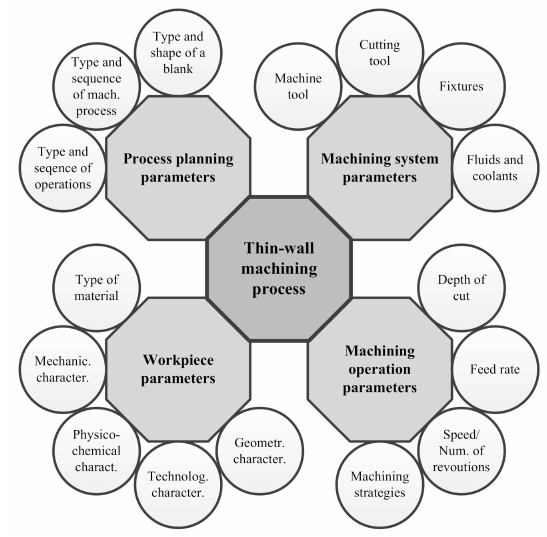
Figure 1. Influential machining parameters for thin-walled